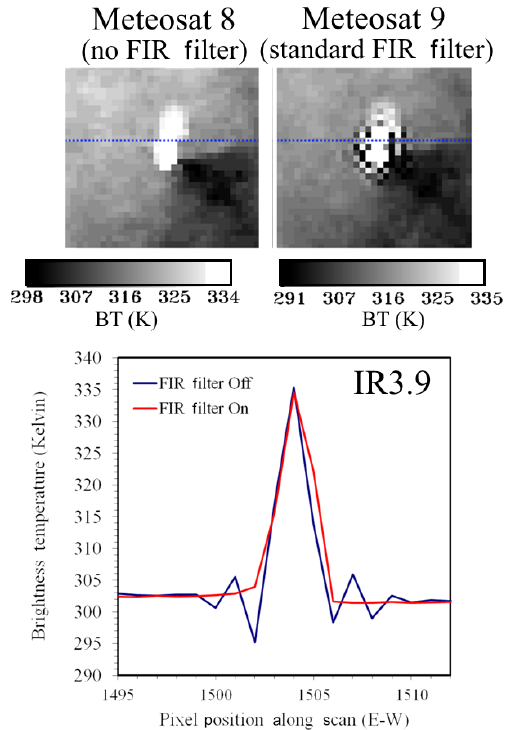
Figure 8. Near-simultaneous Meteosat-8 and Meteosat-9 band 4 (MWIR) imagery of a large, intensely burning (high FRP) fire in Southern Africa taken on 3 September 2007 during Meteosat-8 spe- cial operations when application of the FIR filter was removed tem- porarily. The data appear quite different to that collected with the normally operating